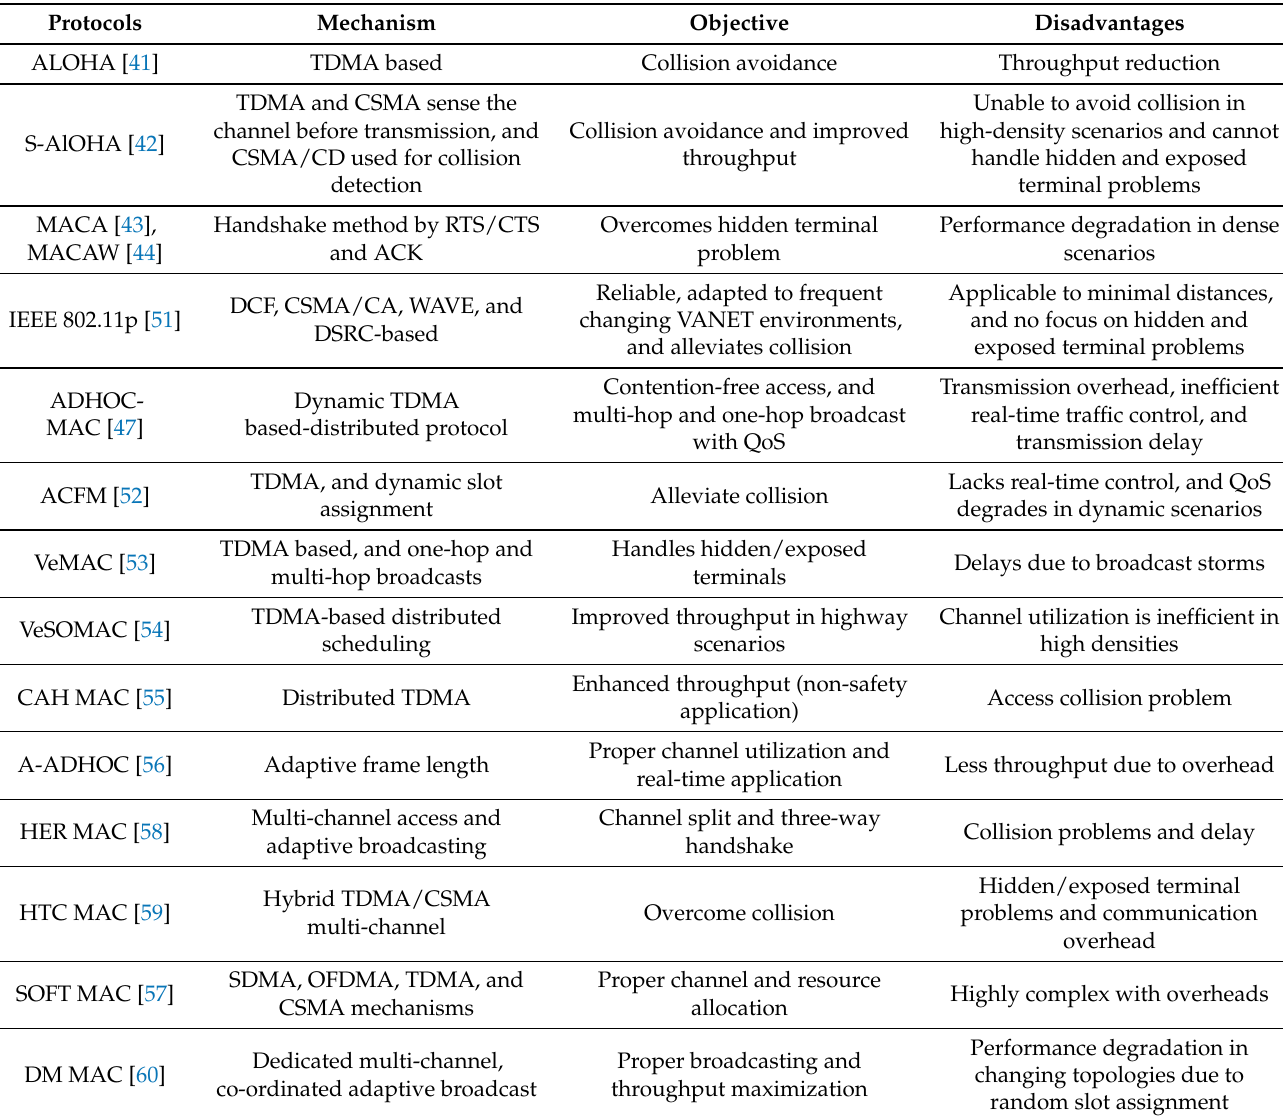
Table 2. Summary of traditional MAC